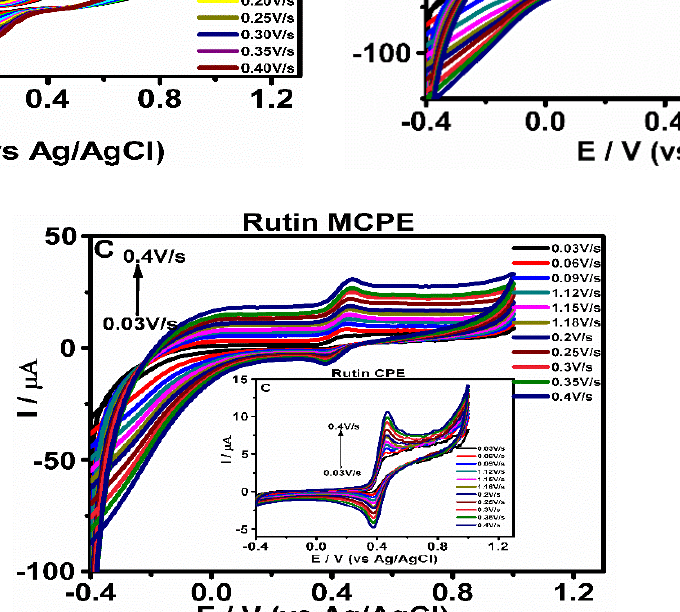
CPE = Carbon Paste Electrode, MCPE = Iron oxide modified carbon paste electrode, I pa = Anodic peak current, ν ½ = Square root of scan rate, (V/s) 1/2 = square root of volt per second.